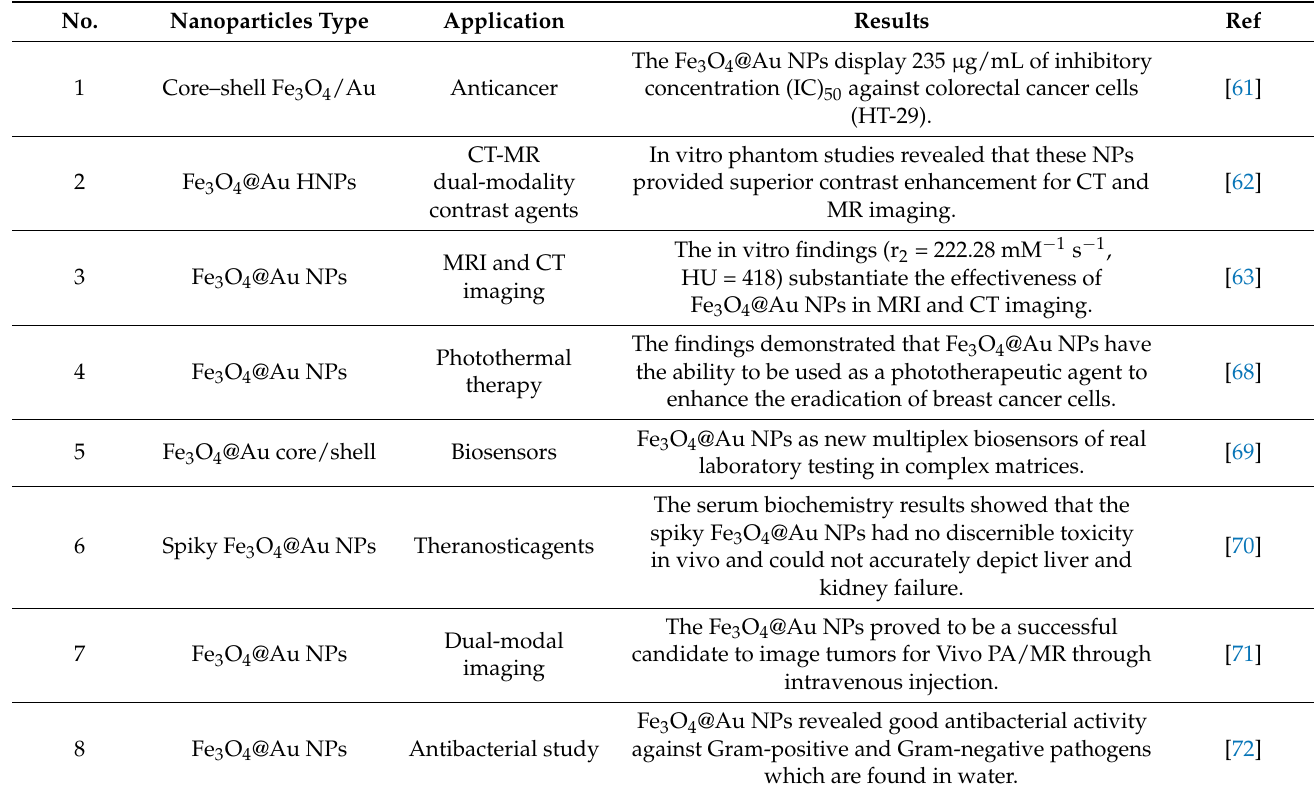
Table 2. Summary of the recently published studies on medical applications of Fe 3 O 4 @Au NPs.